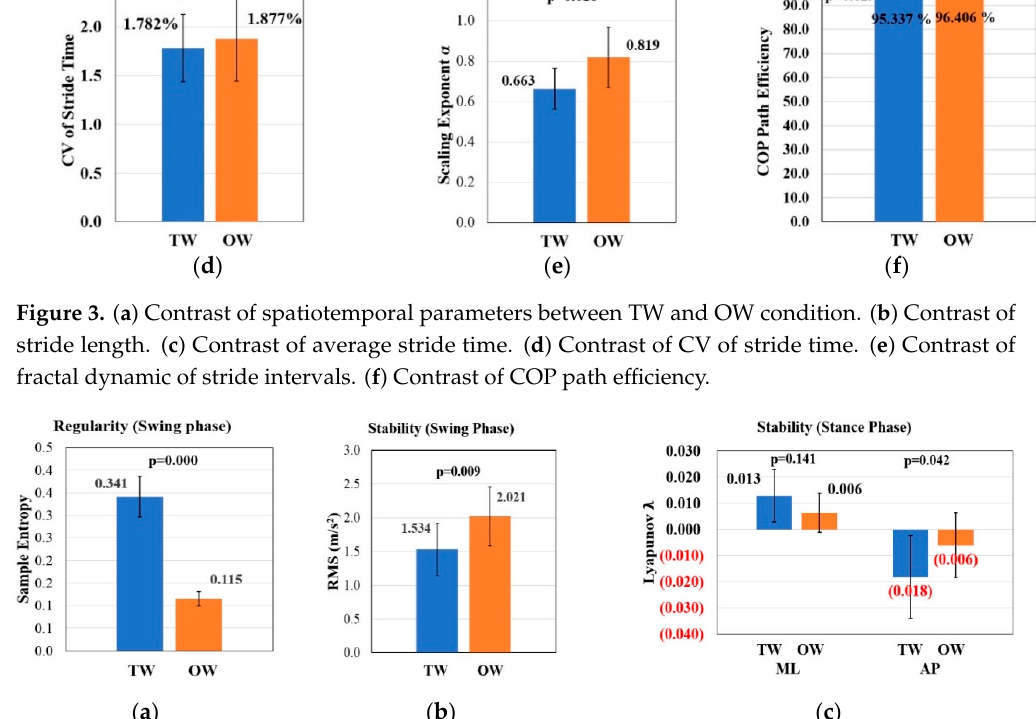
( b ) Figure 5. Comparison of upper trunk stability between TW and OW condition: ( a ) The maximal Lyapunov exponent of lumbar acceleration in ML, V and AP directions. ( b ) The RMS of lumbar acceleration in ML, V and AP directions. 4.2. Correlation between Gait and Upper Trunk Features Although the gait and upper trunk features have been analyzed independently under both OW and TW condition, it is possible that the relationship exists between gait and upper trunk features. The relationship can reflect how people coordinate their gait and upper trunk when walking, and the treadmill can possibly affect the coordination. Canonical correlation analysis is conducted to evaluate the relationship between gait features and upper trunk features. This method can indicate the correlations through Pearson’s correlation coefficients. Table 8 shows the gait and upper trunk